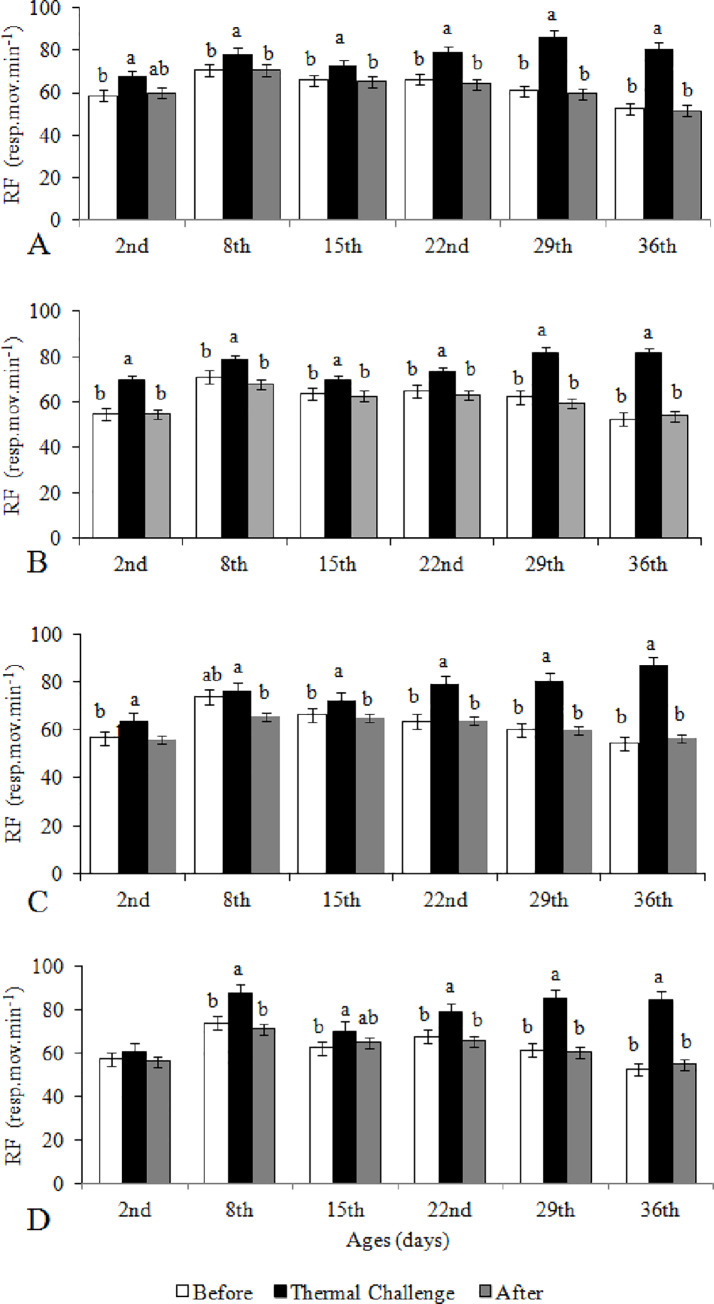
Respiratory frequency (RF) of broilers from eggs incubated at 37.5°C (A,B) and 39°C (C, D) with Long-Short (A, C) and Short-Long (B, D) hatching pattern obtained at the preferred temperature before thermal challenge, at thermal challenge (5°C above thermal preference for 45 min), and upon return to thermal preference after thermal challenge, according to age. Short-Long and Long-Short: time intervals between pippings and between external pipping and hatching (2–8,2+20-26h and 11–18+6-10h, respectively). a-b: means with similar letters do not differ from each other by Tukey test (P ≤ 0.05).